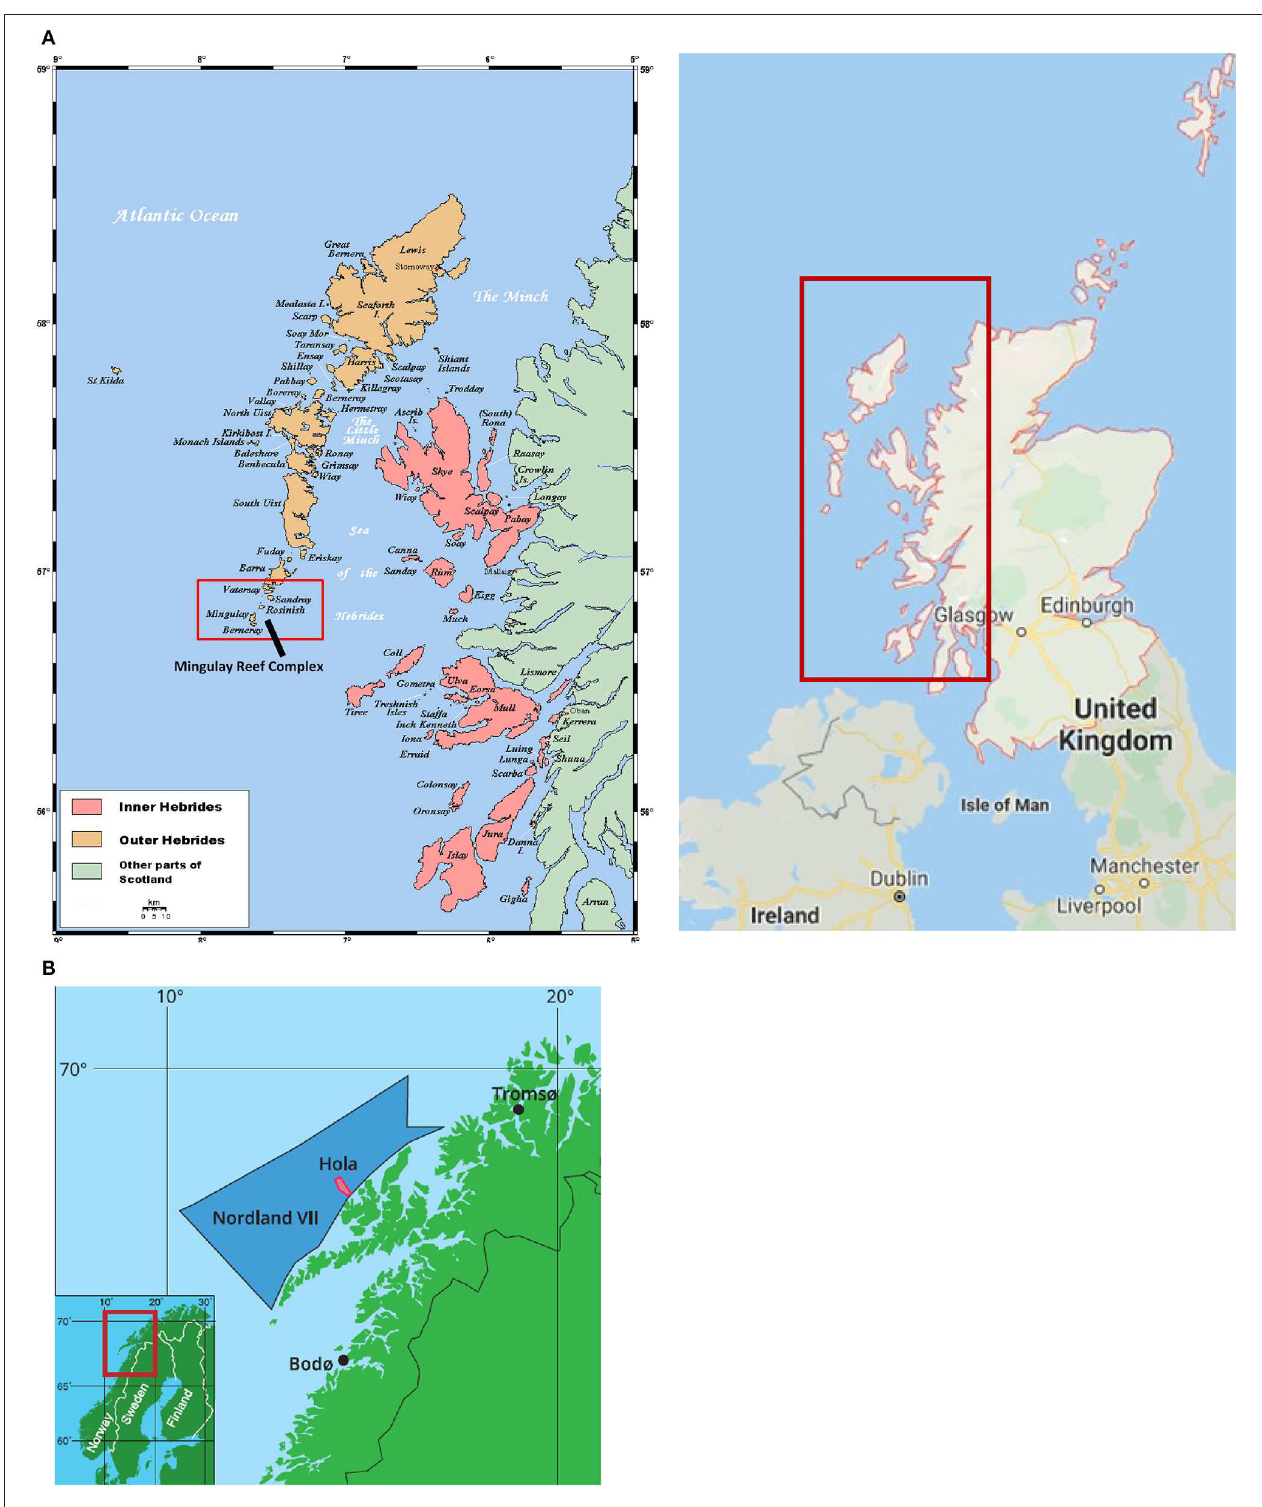
FIGURE 1 | (A) The Mingulay reef complex. (B) The Lofoten-Vesterålen.